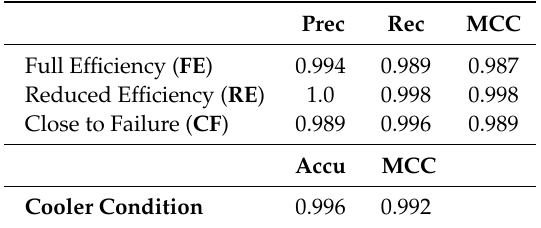
Table 4. Classification results for the Cooler condition at the state and multiclass classifier level.